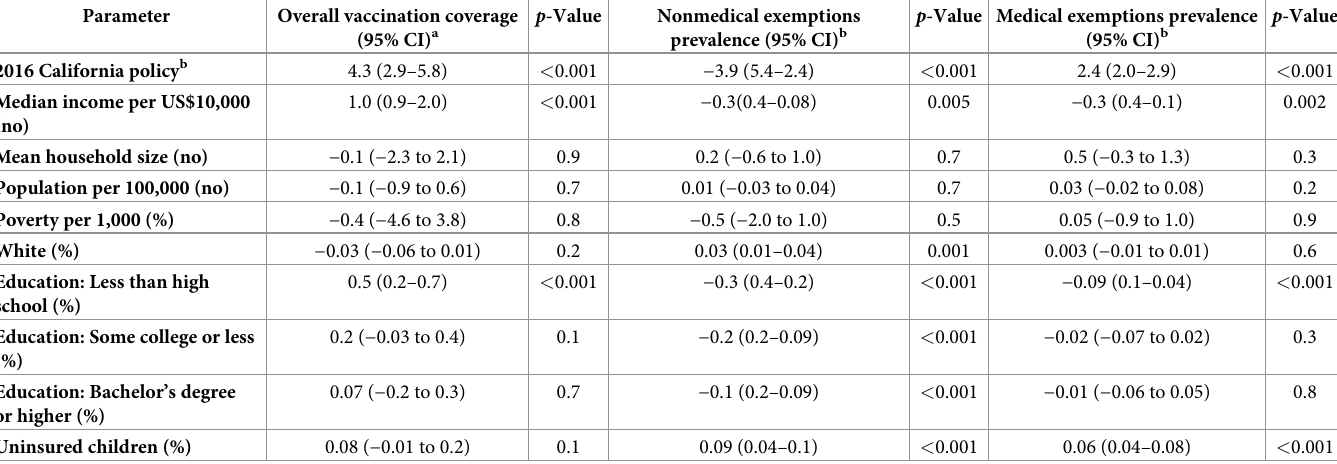
Table 1. County-level analysis of changes in vaccination coverage associated with the 2016 California policy using a difference-in-differences